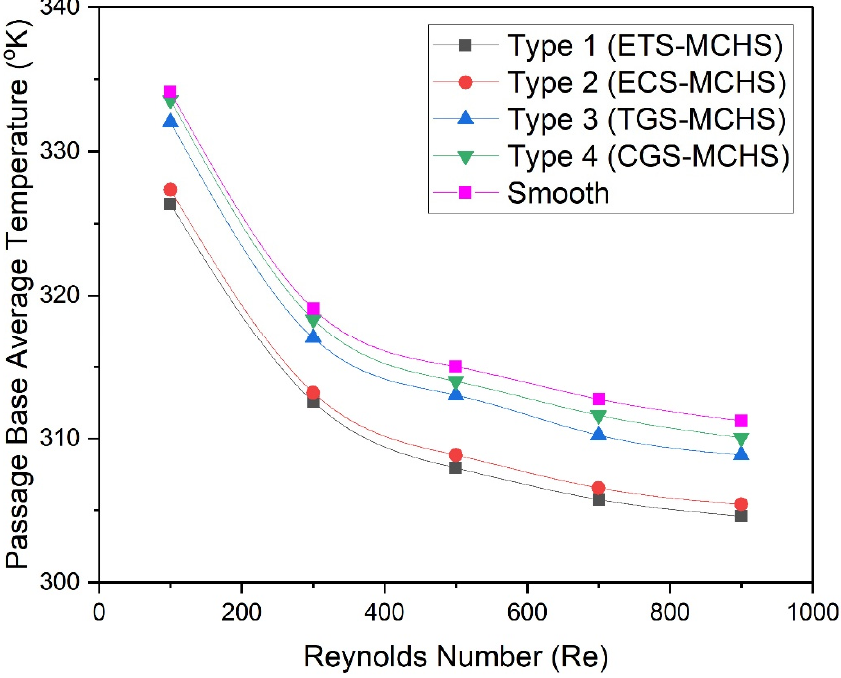
Figure 10. Plots of average temperature at base of passage of MCHS with Reynolds numbers for different design types.